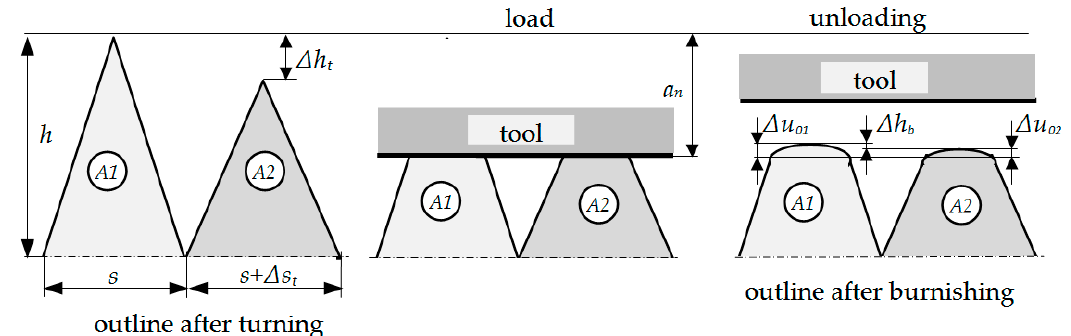
Figure 3. Schematic diagram of the elastic recovery of the material after burnishing: A1 —first asperity, A2 —second asperity after previous machining (turning), h —asperity’s height, ∆ h t —height deviation of asperity after turning, ∆ h b —asperity’s height deviation after burnishing, a b —burnishing depth, ∆ u 01 —elastic recovery of the material of first asperity A1 , ∆ u 02 —elastic recovery of the material of second asperity A2 .